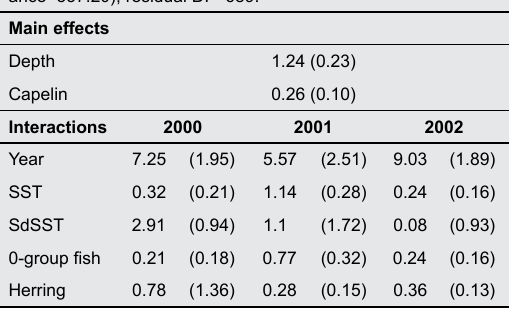
Table 5. Estimates (and SE) of variables in selected model describing fin whale distributions within the study area in 2000, 2001 and 2002. Residual deviance=235.48 (Null devi- ance=357.20), residual DF=689.